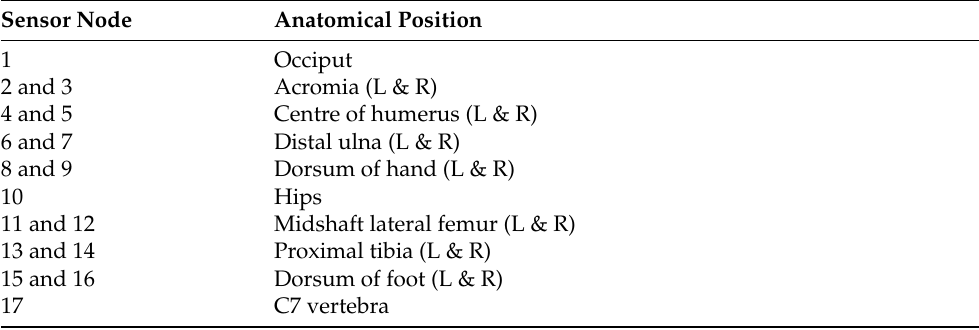
Table 2. Perception Neuron anatomical IMU positions.